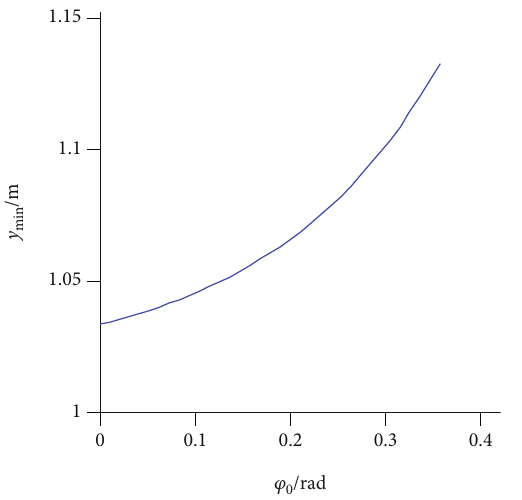
Figure 11: Minimum displacement of the body from the lunar surface.